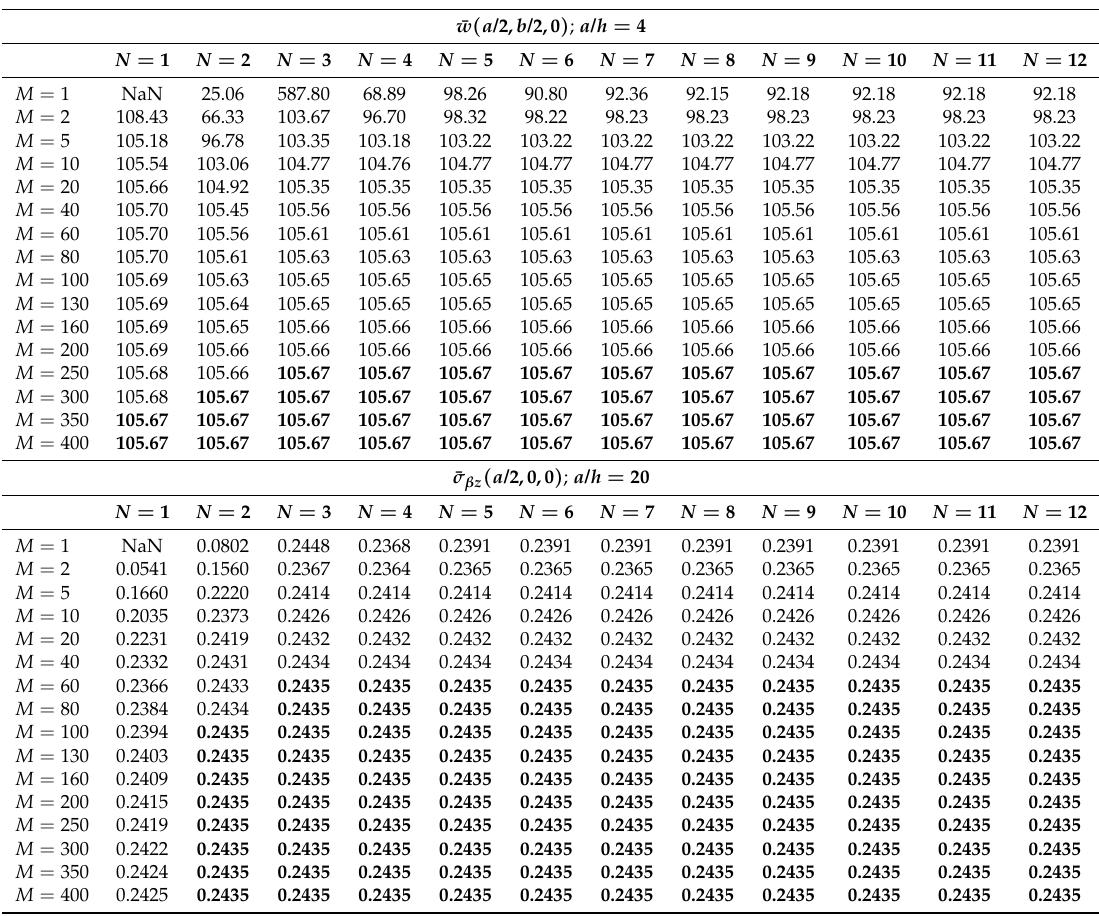
Table 1. Case 1, one-layered Functionally Graded Material (FGM) ( κ = 0.5) plate. Displacement ¯ w for thickness ratio a / h = 4 and stress ¯ σ β z for thickness ratio a / h = 20, both evaluated in the middle of the thickness and given as dimensionless values. One physical layer ( N L = 1) divided into M global mathematical layers. 3D reference solution in Brischetto [23]. NaN means Not a Number. Digits given in bold are the correct